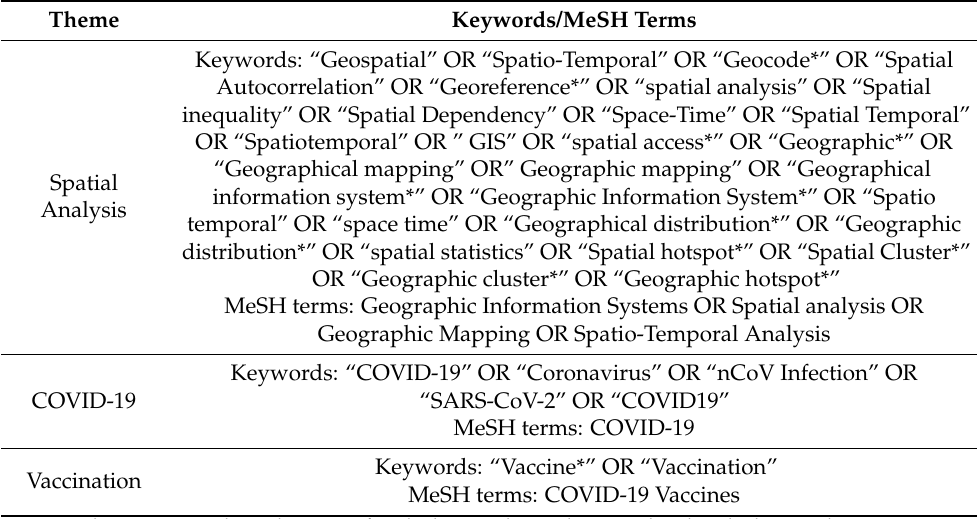
Table 1. Articles’ search strategy in